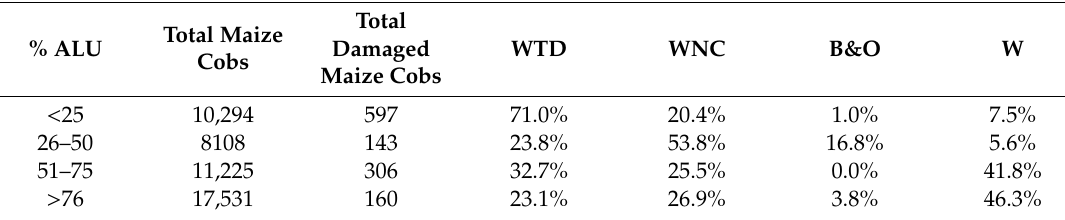
Table 2. Total maize cobs, total damaged maize cobs and percentage of damaged maize cobs by di ff erent factor (WTD = white-tailed deer; WNC = white-nosed coati; B&O = birds and others; W = wind), on all maize fields within each of the four ranges of percentage of agricultural land use (%ALU) within a 100 m bu ff er around each field.